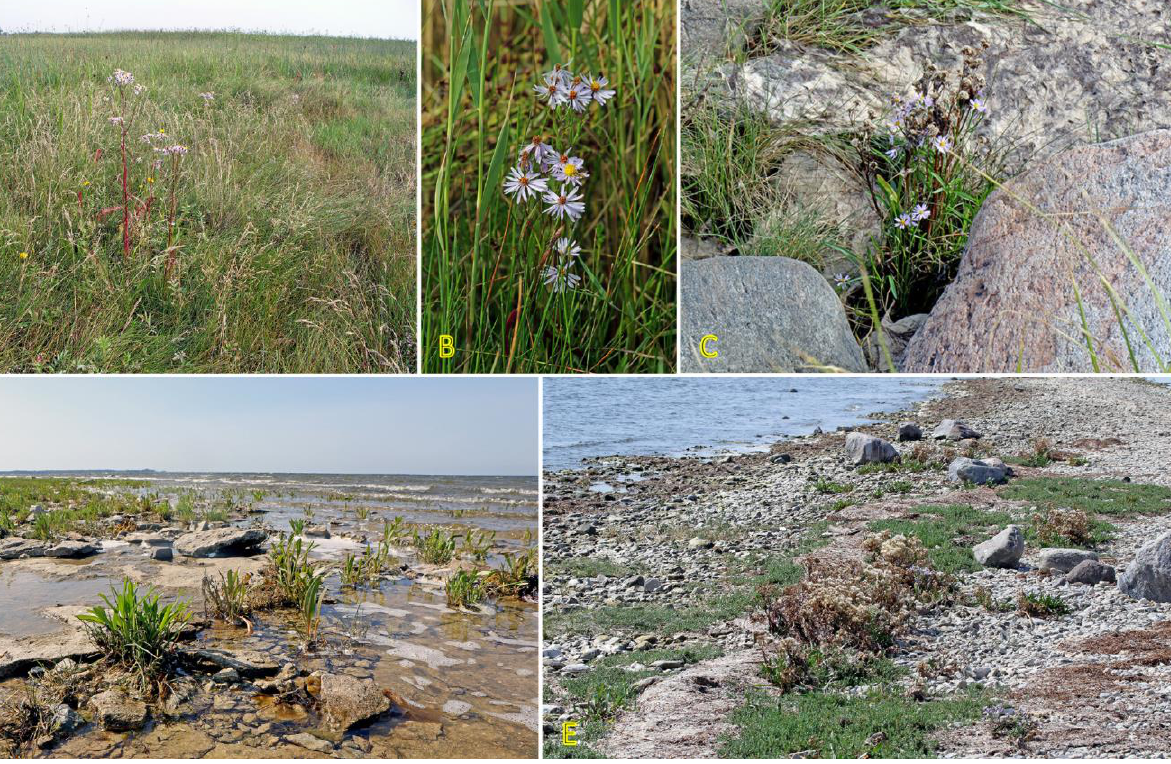
Figure 7. Tripolium pannonicum plants in a salt- affected wet meadow in Liepāja, Latvia ( A ), a coastal wetland together with Phragmites australis on the island of Kihnu, Estonia ( B ), on a stony beach in Matsi-Sömeri, Estonia ( C ), on a rocky beach on the island of Saaremaa, Estonia ( D ), on a pebble beach together with Lysimachia maritima on the island of Hiiumaa, Estonia ( E ).